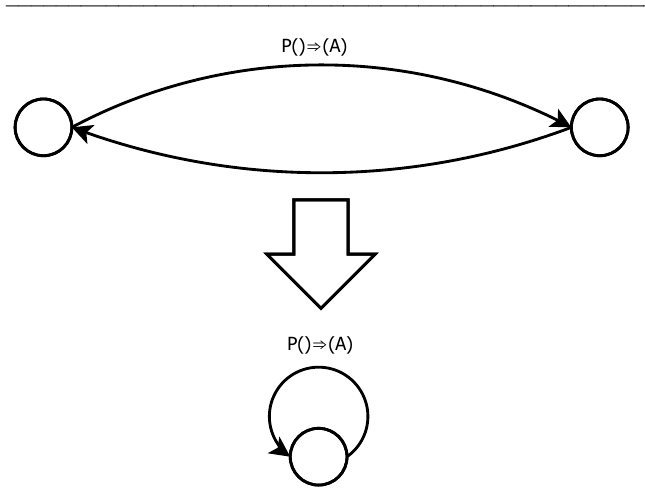
Fig. 12. Empty edge elimination.